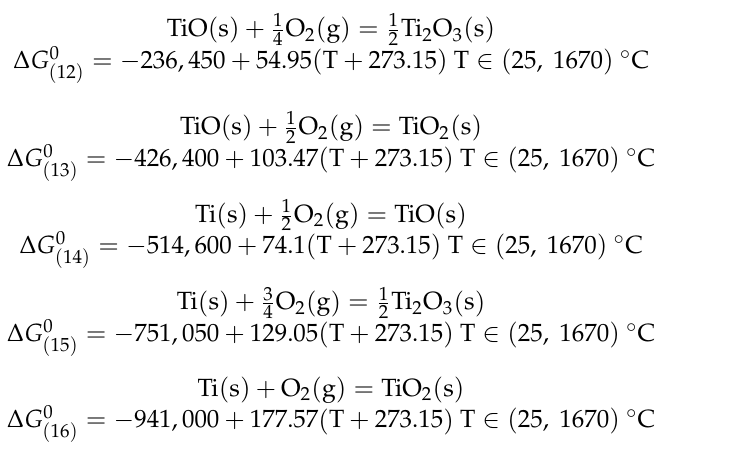
Figure 8. Relationship between Gibbs free energy-temperature of oxidation reaction of Ti.